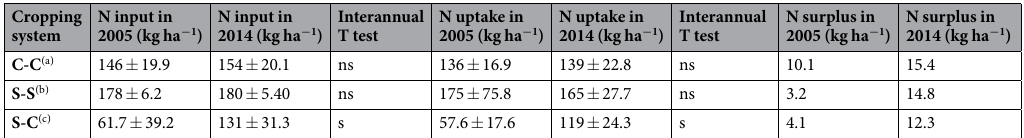
Table 3. Nitrogen input, uptake and surplus for different cropping systems in both 2005 and 2014. N input: N fertilizer + N fixation, N fixation ≈ 146 kg ha − 1 42 . Data are means ± SD. ns means no significant difference, P <